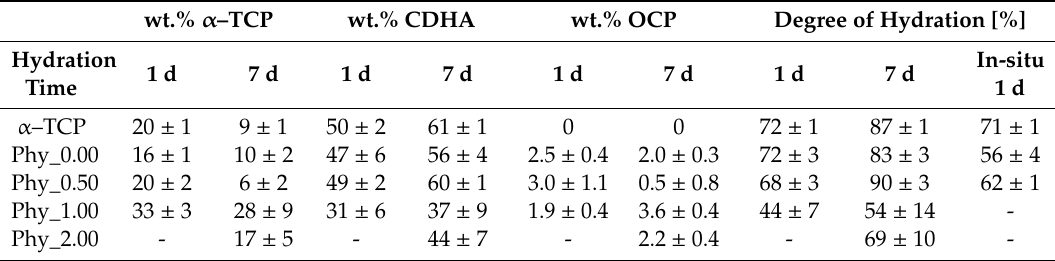
Table 2. The quantitative phase composition and degree of hydration of samples composed of α –TCP and CDHA (weight ratio 9:1) with di ff erent amounts of sodium phytate after 1 d and 7 d of hydration; a 0.2 M Na 2 HPO 4 aqueous solution was used as the mixing liquid with an L / P of 0.3 ml / g Powder ; the samples were stored at 37 ◦ C.